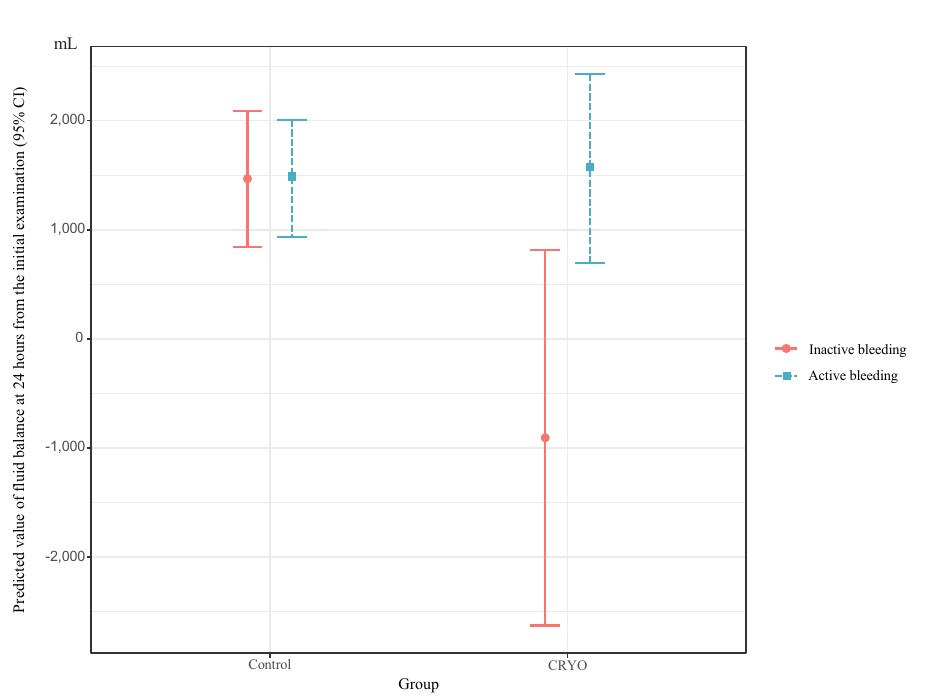
Figure 3. Association between use of CRYO and fluid balance at 24 h from the initial examination by presence of active bleeding. CI, confidence interval. CRYO,